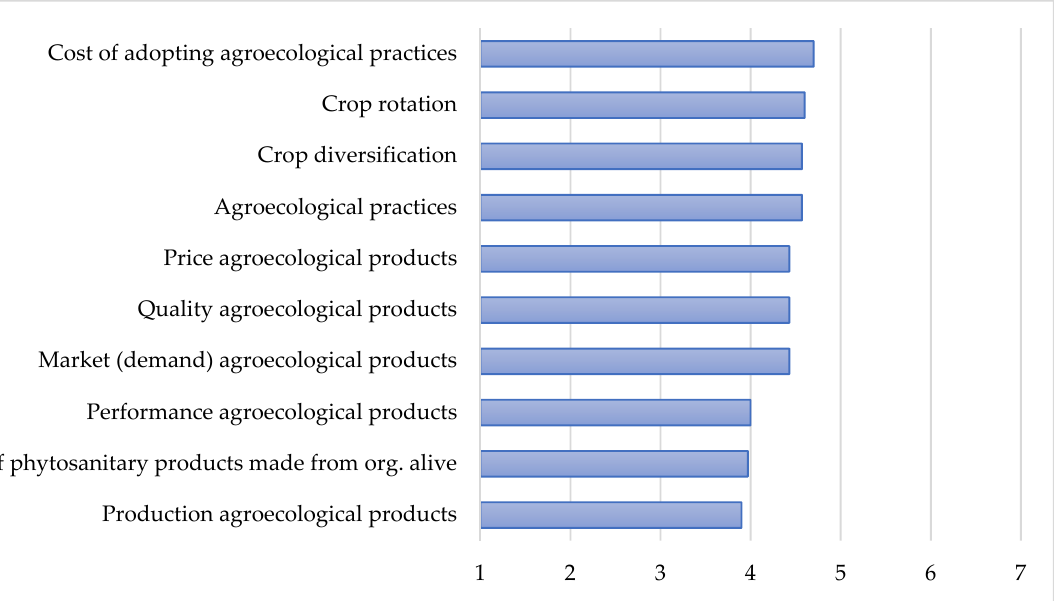
Figure 2. Scaled average according to the degree of knowledge about different aspects of agroecology. 53% of farmers had very little information on agrochemicals, 57% of farmers had very little information on the negative health effects of agrochemicals and, as Figure 3 shows, 83% of farmers affirmed that agrochemicals are a health risk.